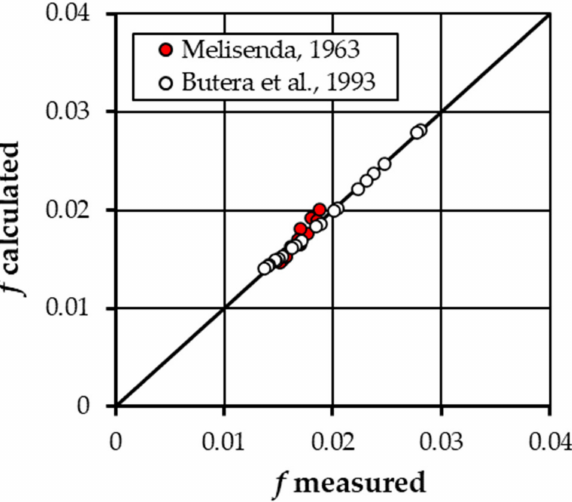
Figure 6. Comparison between the measured Darcy-Weisbach friction factor values, f m , and those calculated, f c , by Equation (3) with Г f estimated by Equations (12) and (13) with the coefficients a = 0.402, b =1.201 and c =